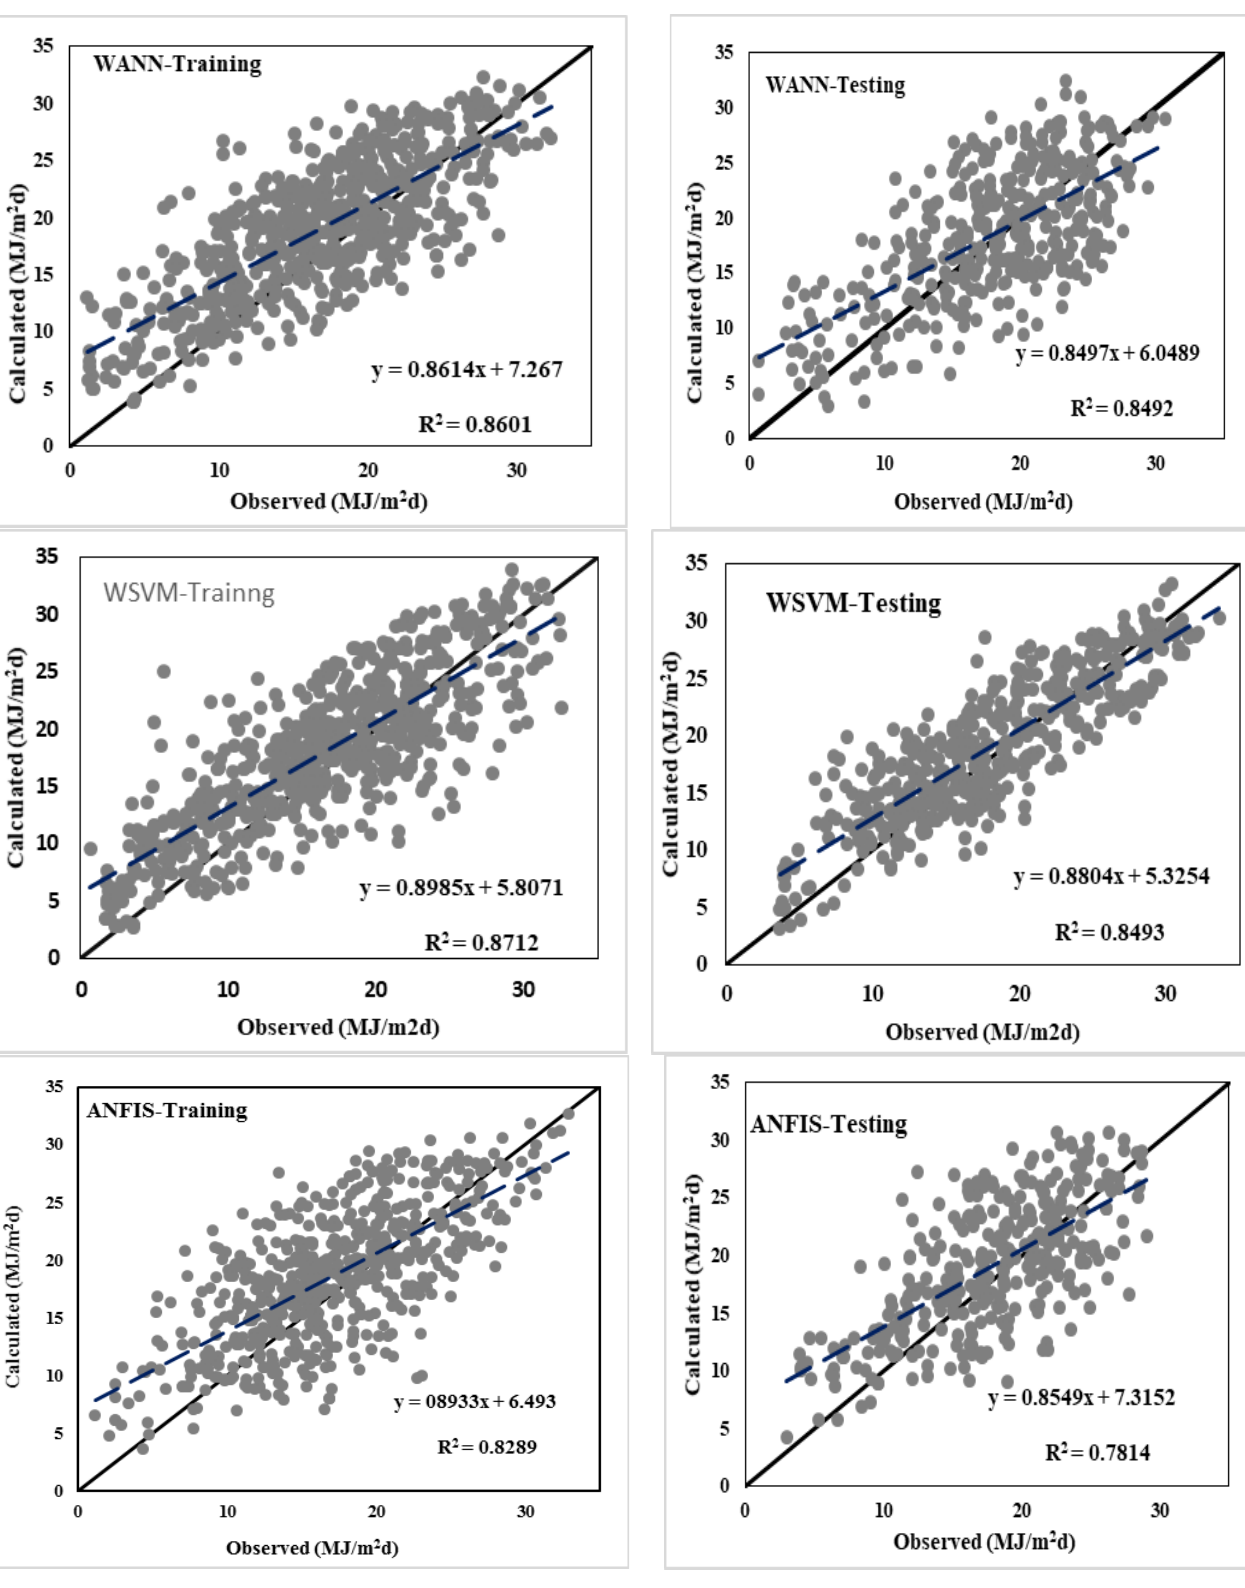
Figure 3. Correlation between radiation intensity (Rs) assessed by WANN, WSVM, and ANFIS methods and observed values at Dhi Qar station in two stages of training and testing.